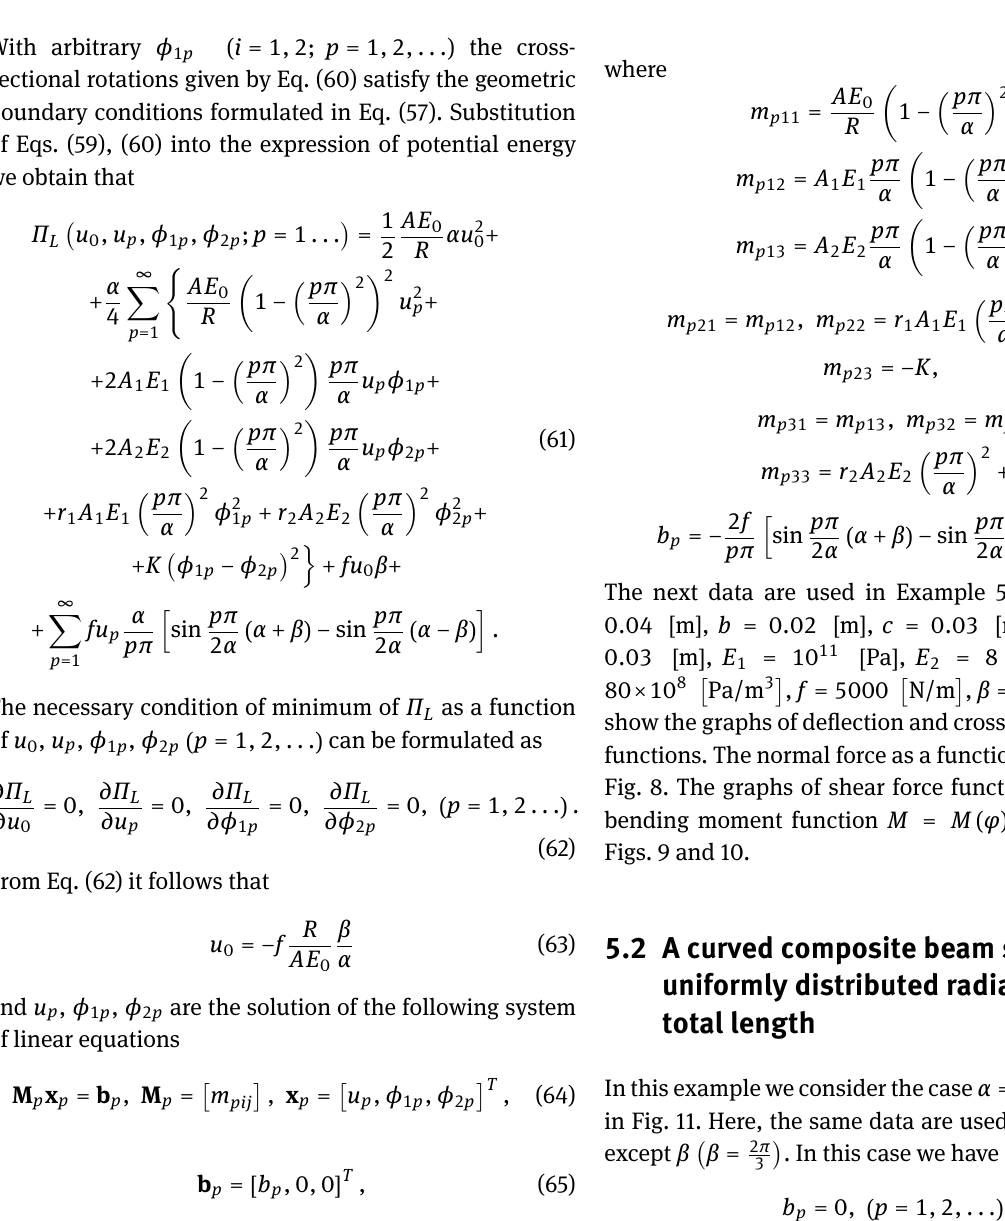
Figure 6: The graph of ϕ 1 = ϕ 1 ( φ ) .